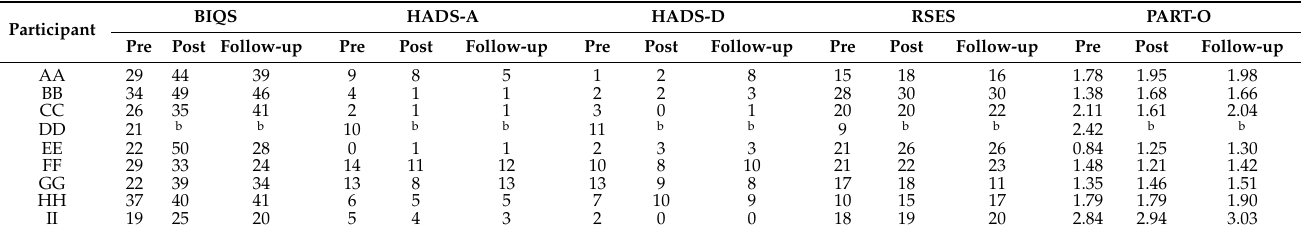
Table 4. Participants’ pre-treatment, post-treatment, and follow-up raw scores for secondary outcome questionnaire measures.